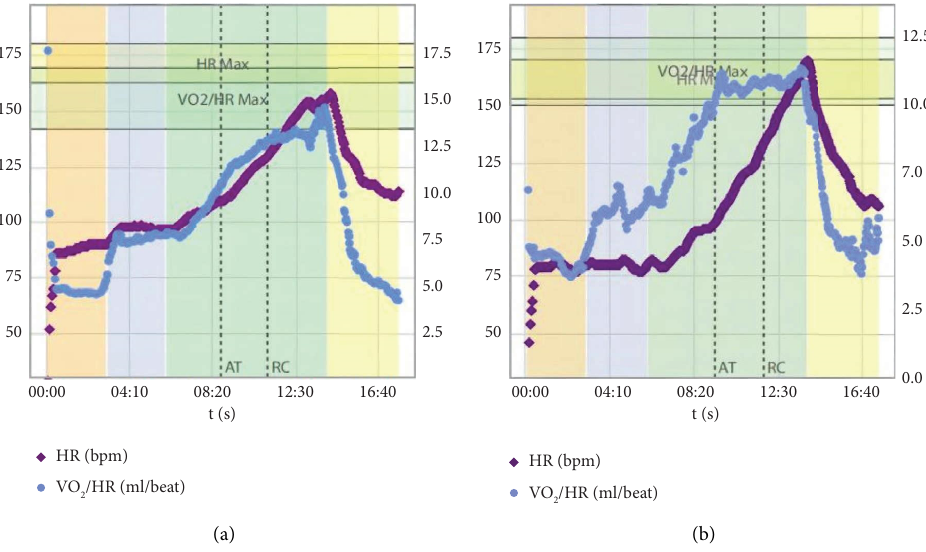
Figure 2: Te characteristic examples for VO